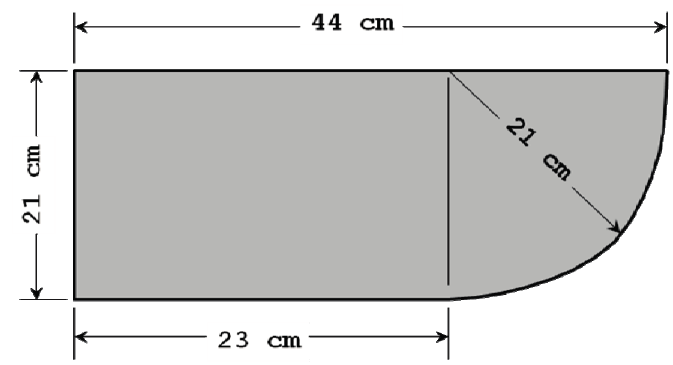
Figure 18. Dimension of the constructed wing [9].